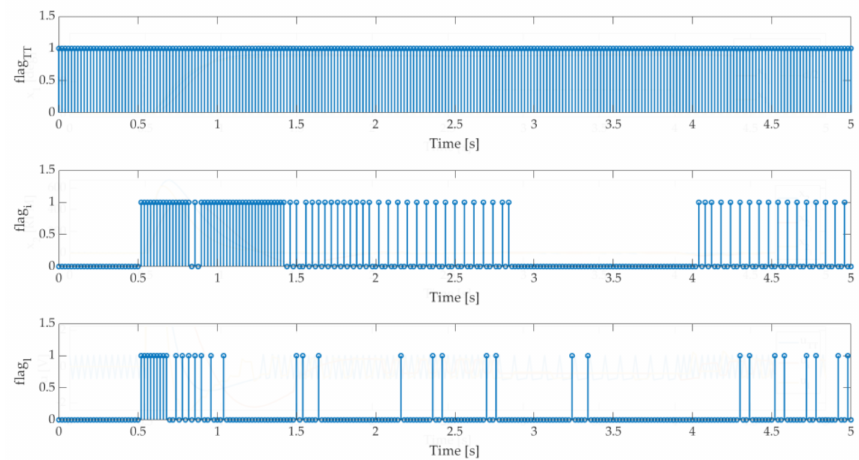
Figure 9. Update flags of controllers u TT , u i and u l during disturbance rejection